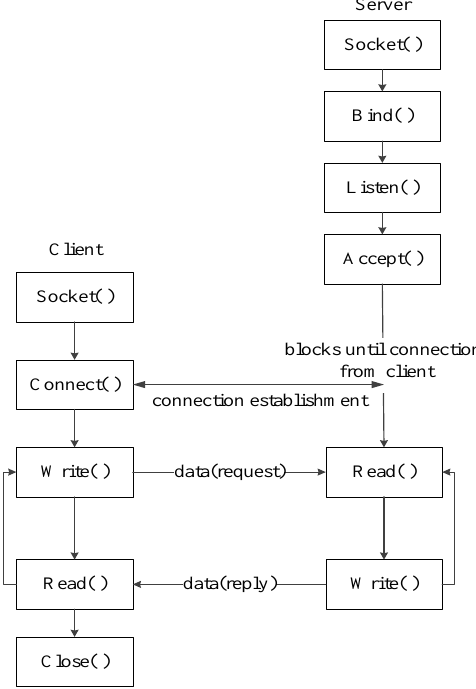
Figure 1. Connection-based sockets interaction.